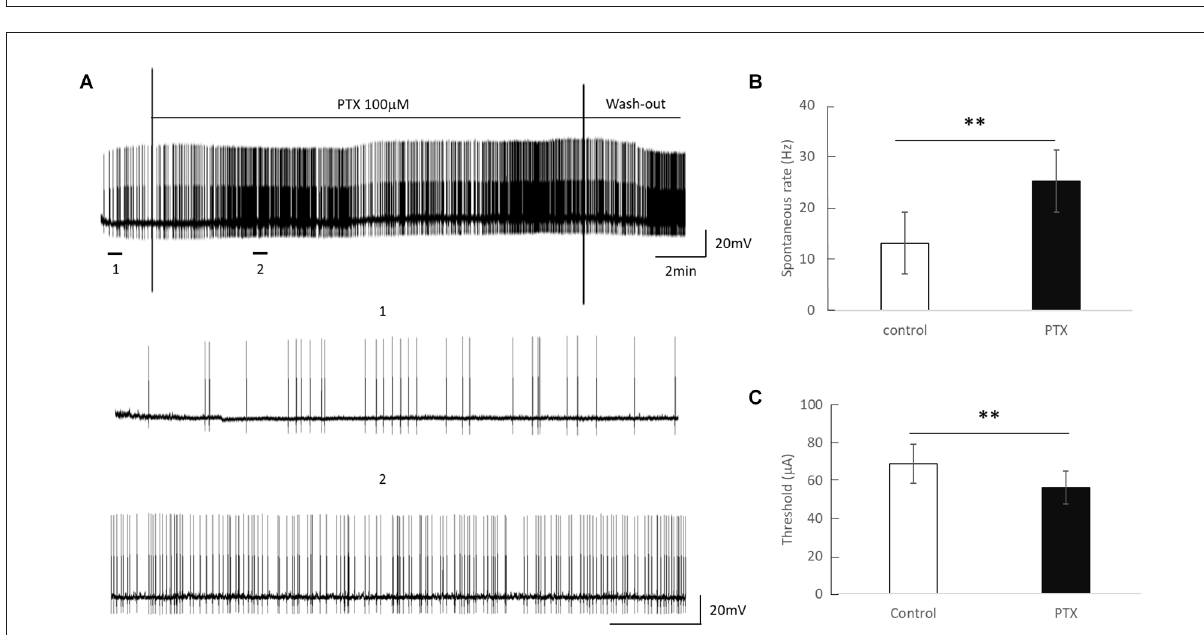
FIGURE3 The effect of PTX (100 µ M) on the spontaneous spike rate of RGCs. (A) Spontaneous spikes of an RGC before and after application of PTX. One and two show zoomed-in traces for before and after application of PTX respectively. (B,C) PTX significantly increased spontaneous spike rate ( ∗∗ p < 0.01) and decreased the threshold ( ∗∗ p < 0.01) compared to control.